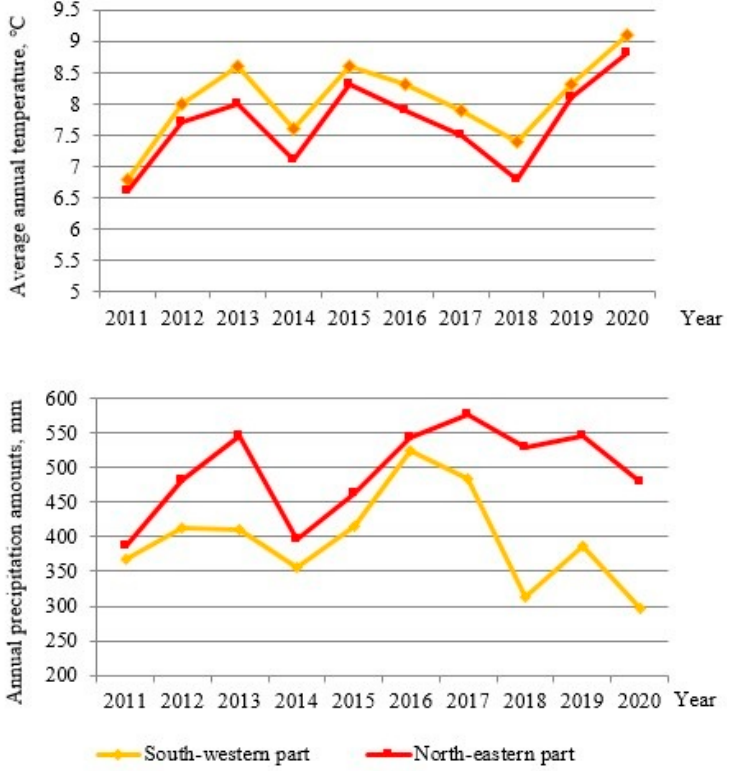
Figure 2. Climatic characteristics of the steppe zone of the south of the Russian Plain (based on data from weather stations in the cities of Uryupinsk and Saratov). Location of the meteorological station in Uryupinsk (south-western part): latitude 50.80 longitude 42.00. Location of the meteorological station in Saratov (north-eastern part): latitude 51.60 longitude 46.00 [24].